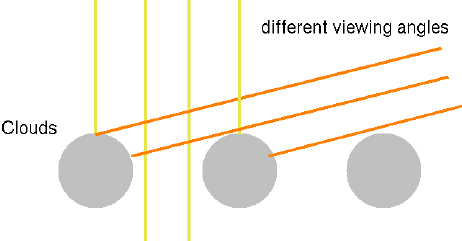
Figure 6. Illustration of the slant geometry effect. For a satellite zenith angle of 0 the cloud coverage would be 0.5, but for the slant geometry it would be